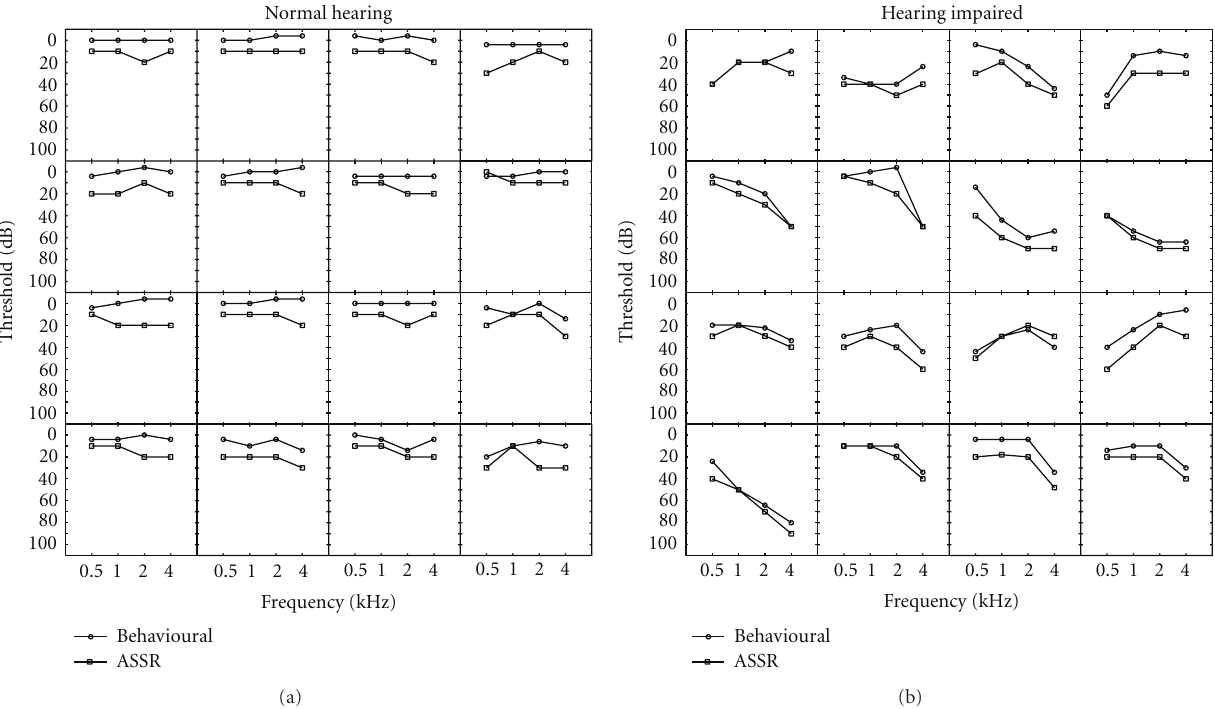
Figure 1: Behavioural and multiple ASSR thresholds at 500, 1000, 2000, and 4000Hz plotted for the right ears of 16 normal-hearing subjects (a) and 16 hearing-impaired subjects